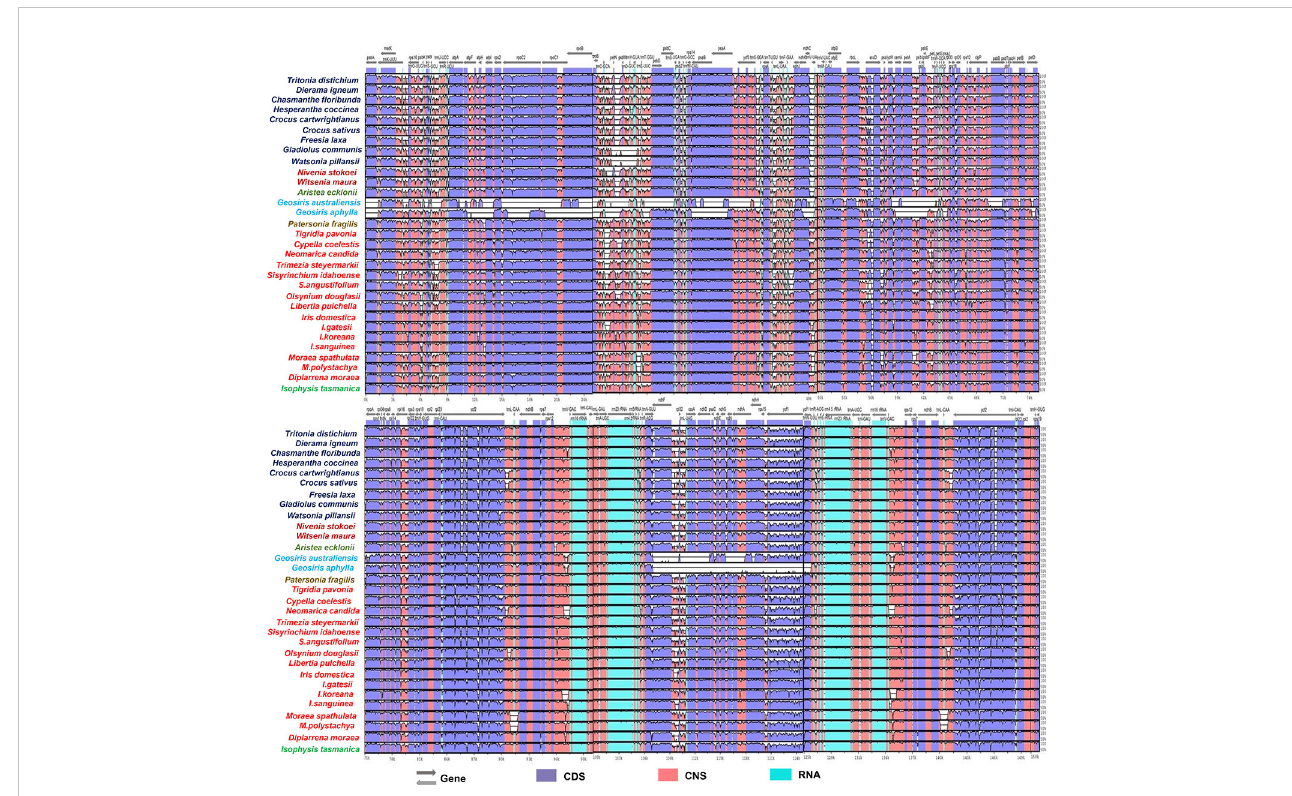
FIGURE 2 Sequence identity plot comparing 31 CP genomes with I. loczyi as a reference using mVISTA. CDS, coding sequences; CNS, non-coding